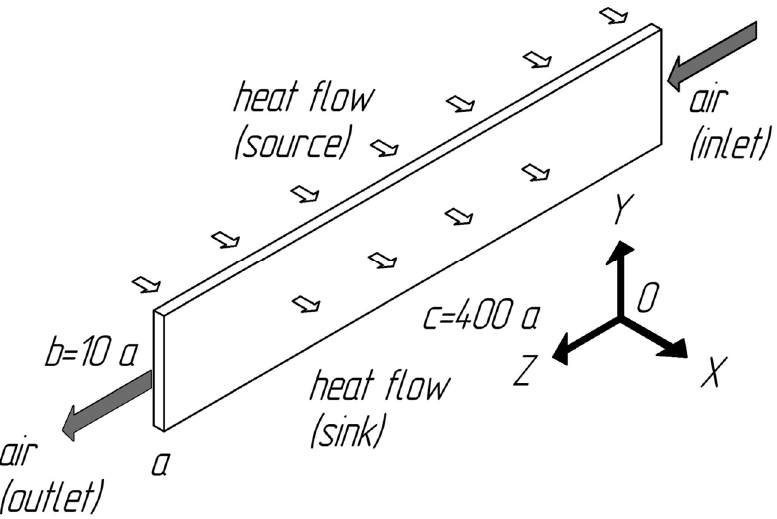
Figure 2. Scheme of the modelling